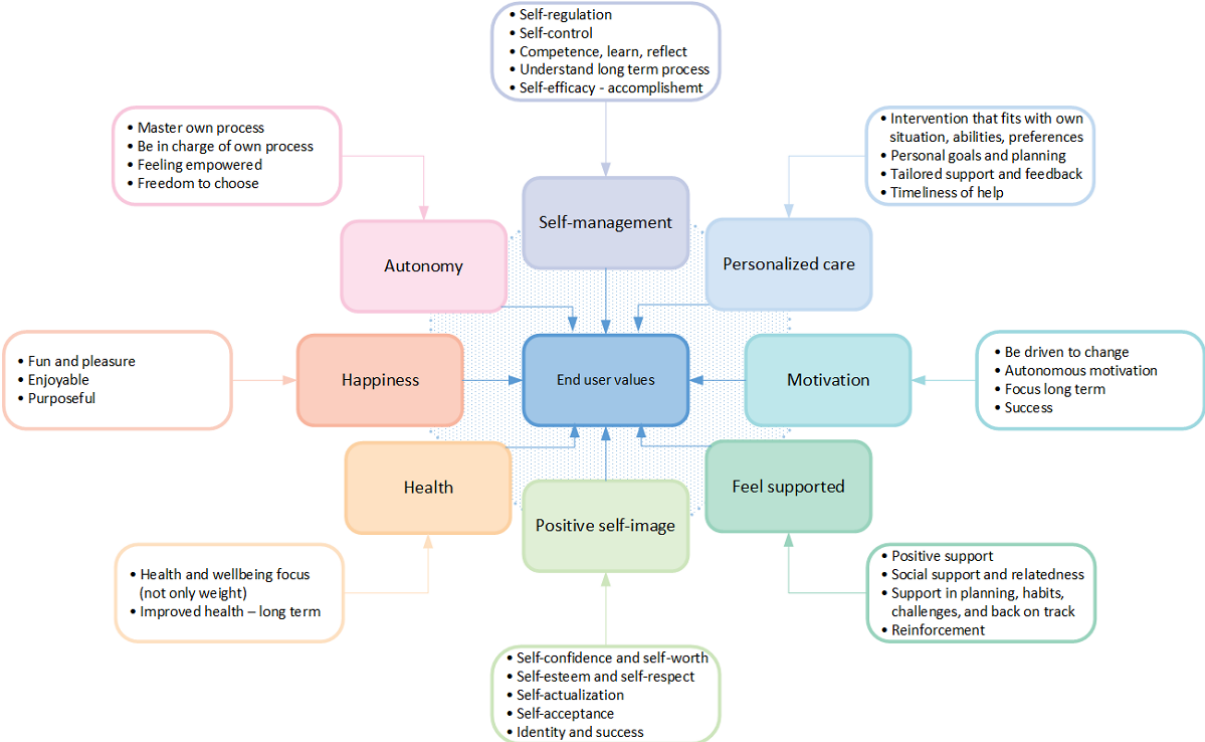
Figure 5. Overview of identified key end user